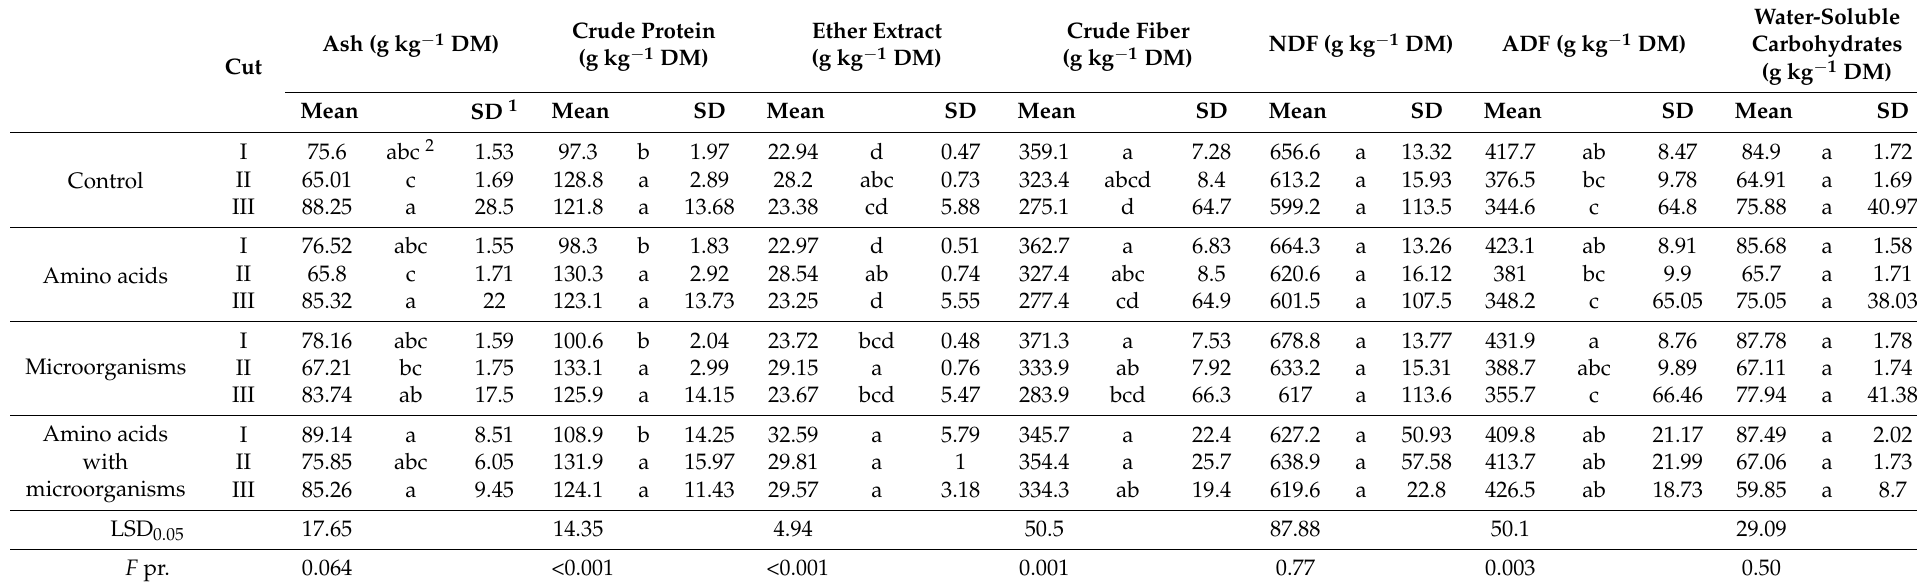
Table 2. The effect of effective microorganisms and amino acids on the chemical composition of grassland